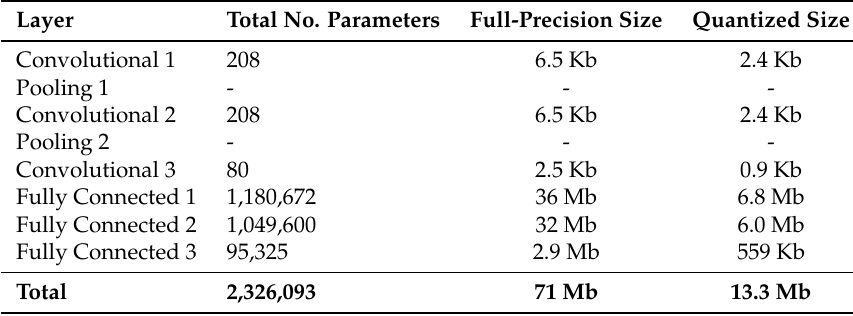
Table 2. Quantized vs. full-precision CNN